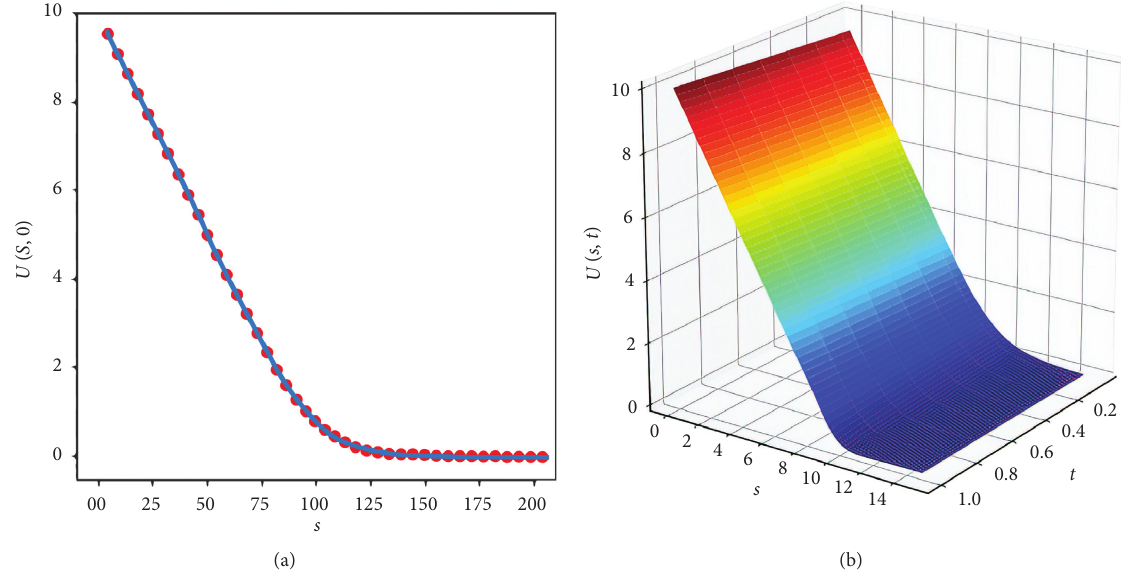
Figure 9: Plots of the approximated solutions of Example 3 when the number of hidden neurons is 60 and d t � 1/20. (a) U ( S, 0 ) (the red dotted plot is the approximate solution). (b) U ( S,t ) , t ∈ [ 0 ,T ]